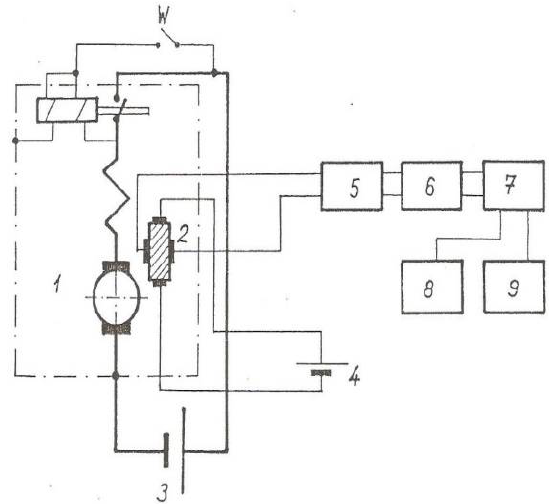
Figure 9. Block diagram of the stand: 1—starter, 2—Hall sensor, 3—battery, 4—Hall sensor supply, 5—signal amplifier, 6—protective system, 7—computer with an analogue-to-digital converter, 8—monitor, 9—printer.